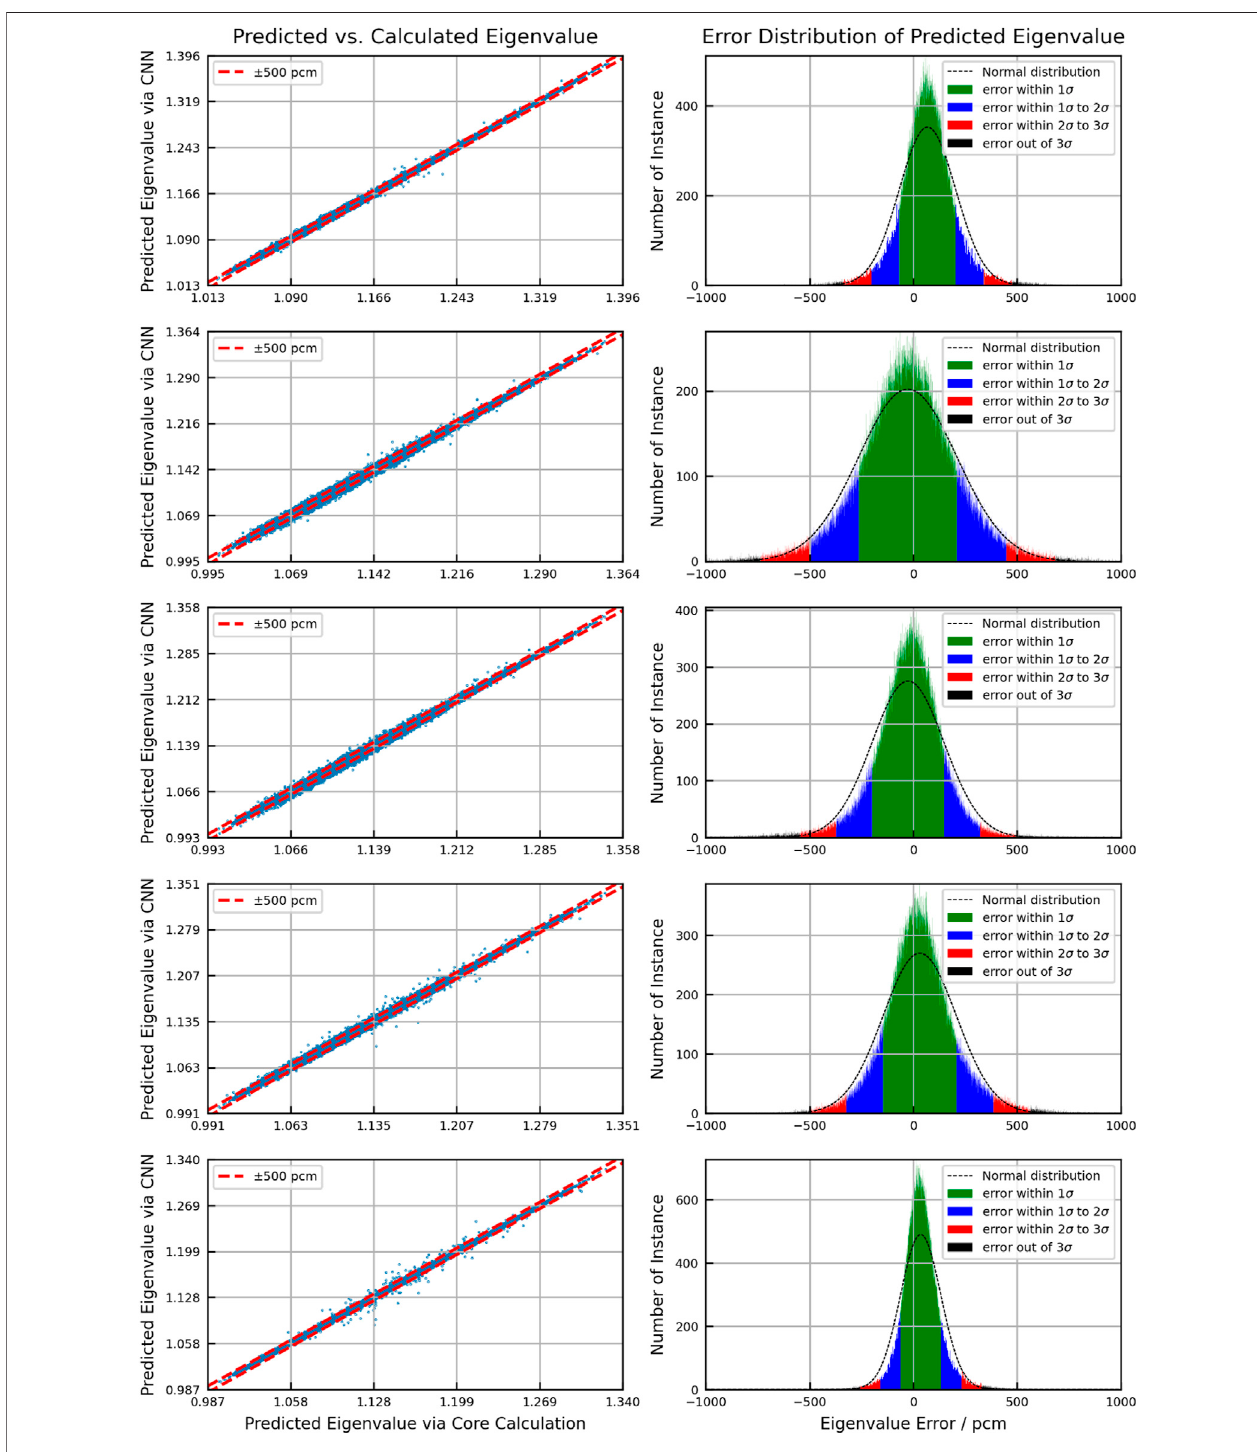
FIGURE 6 | Eigenvalue predicted accuracy of the